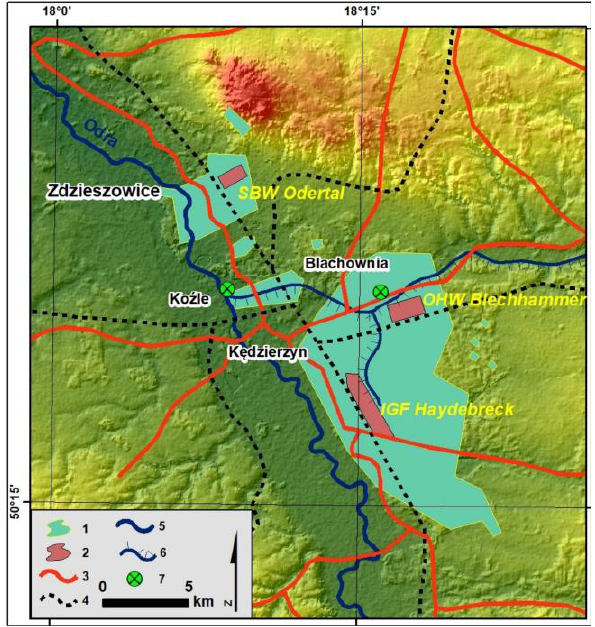
Fig. 2. Location of the study area. 1 – surface bombing areas, 2 – former synthetic fuel plants, 3 – roads, 4 – railroads, 5 – rivers, 6 – canals, 7 – ports (source: Waga et al., 2022b,